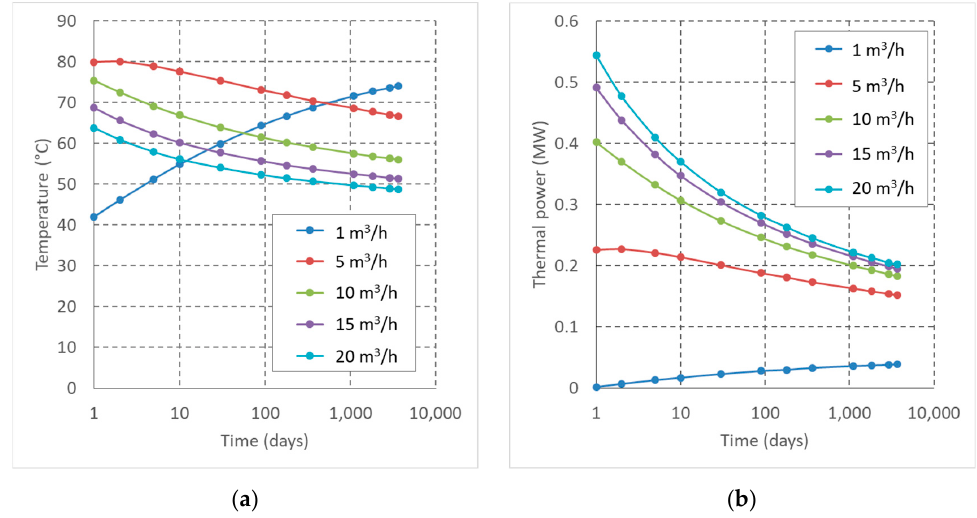
Figure 7. ULHE results (Configuration U0–R = 0.5). ( a ) Thermal power vs time after startup and ( b ) temperature vs time after startup.